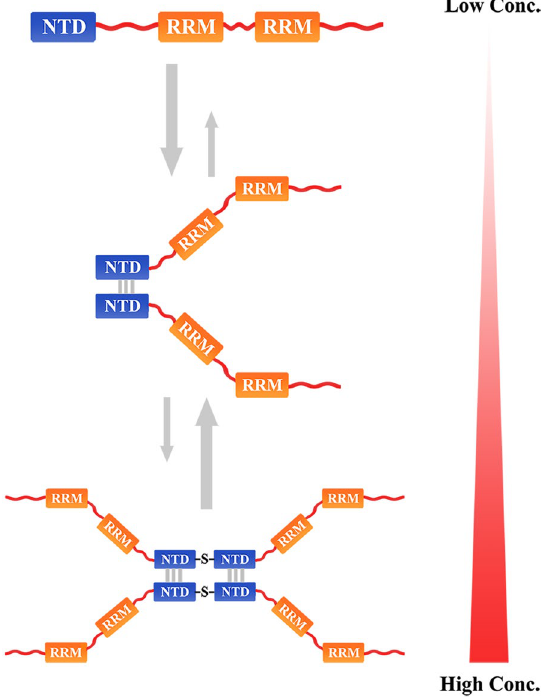
Figure 7. Schematic representation for the oligomerization of TDP-43. The model proposes that TDP-43 NTD mainly forms a dimer via residues Leu71 and Val72 around the β 7-strand, and then transforms into a tetramer via disulfide formation at high protein concentrations. The NTD dimerization or tetramerization may protect TDP-43 against aggregation and is required for splicing activity of